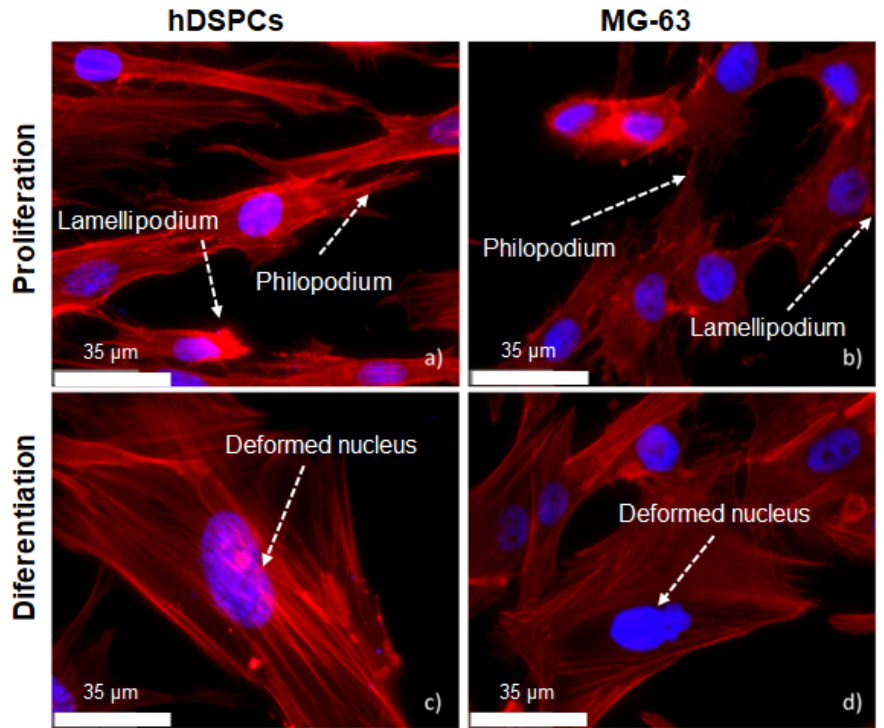
Figure 15. Immunocytochemical staining for F-actin (in red), and nuclei counterstained with DAPI in the hDPSCs and MG-63 cells cultured in conventional medium (first line) ( a , b ) and in differentiation medium (second line) ( c , d ). They were all cultivated on flat surfaces.